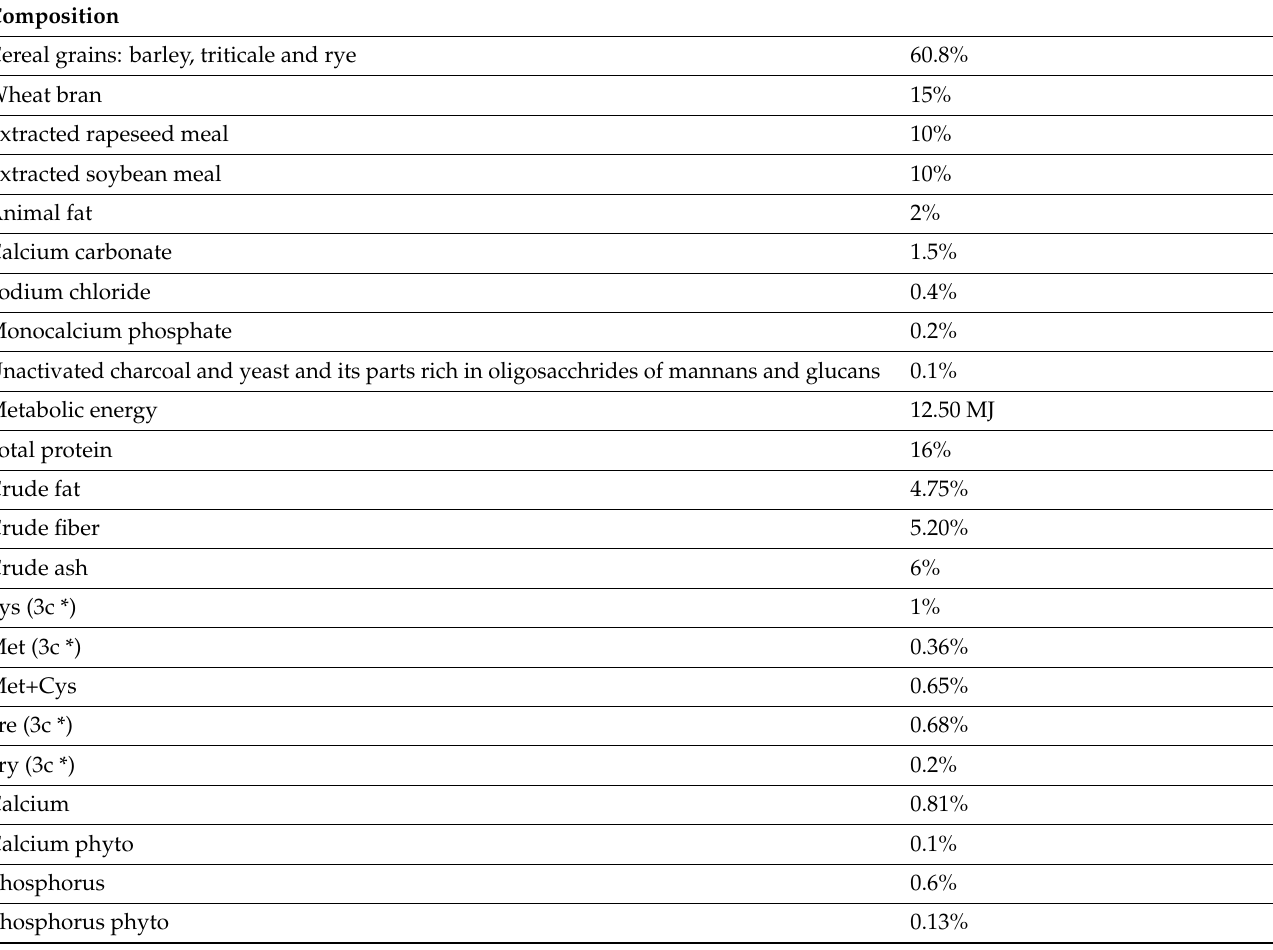
Table 1. Ingredient composition (% wt/wt) of the basal